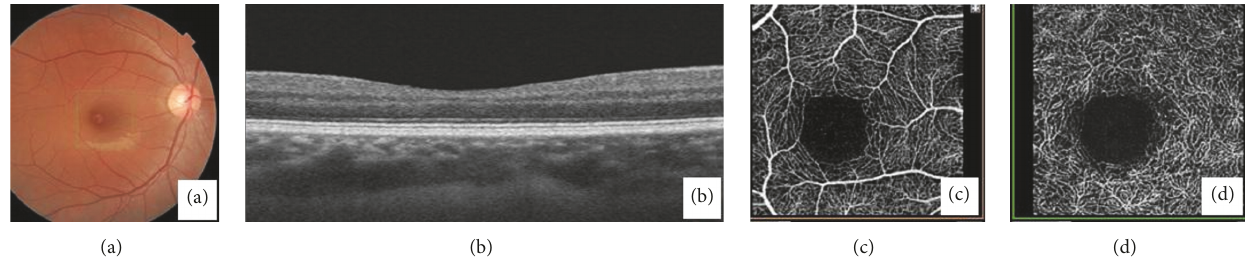
Figure 1: (a)Fundus photo and OCT of macula (b) at initial presentation. Note the well-described perifoveolar capillary plexus in both superficial and deep plexus (c and d).